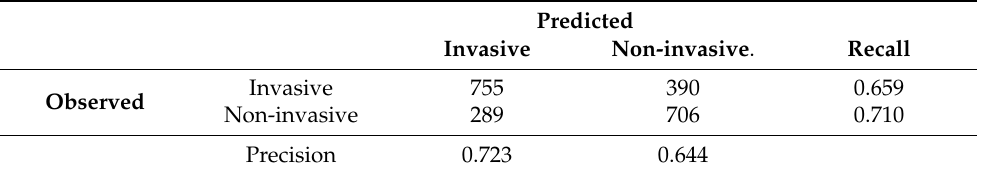
Table 4. Confusion matrix of the MobileNetV2 (ImageNet weights, average pooling, and 384 × 512